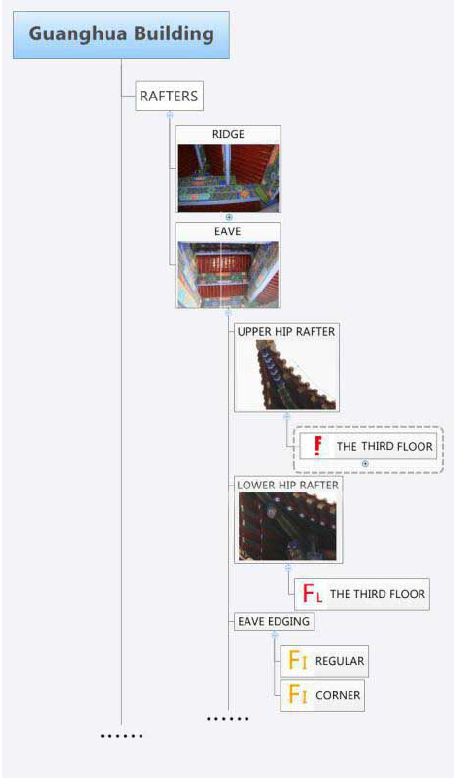
Figure 4. The units structure tree Figure 5. The structure tree for the